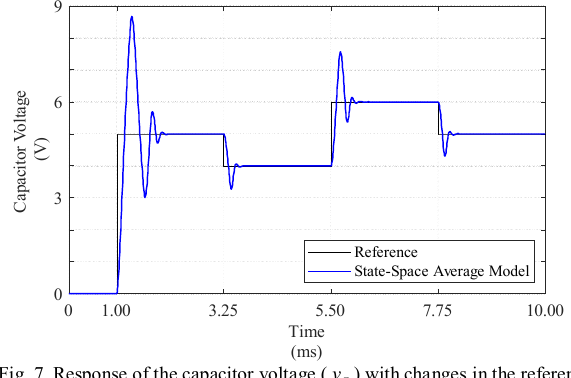
Fig. 7. Response of the capacitor voltage (